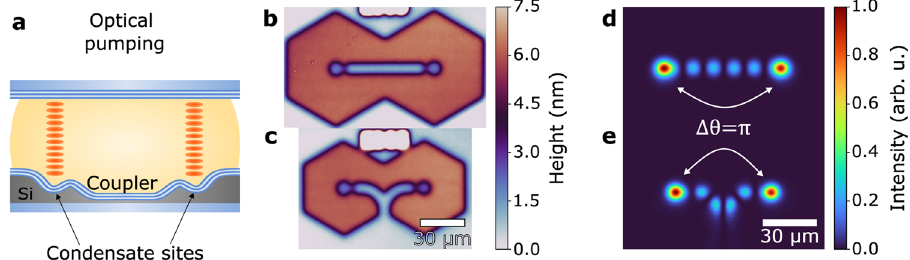
Fig. 1 Overview of the experiment and investigated coupling structures. a Schematic representation (cross section) of the microcavity. The cavity consists of two highly re fl ective mirrors and is fi lled with a rhodamine 6G dye solution. A nanostructured mirror creates two circular con fi ning potential, where photon BECs form after local excitation with an optical pump beam. The coupling is determined by the potential landscape between the condensates. b , c Height map of the structure for the direct and Y-coupling potential, respectively. d , e Measured photon densities under symmetric excitation for the direct coupler and the Y-coupler, respectively. These images are acquired by imaging the light that leaves the microcavity onto a